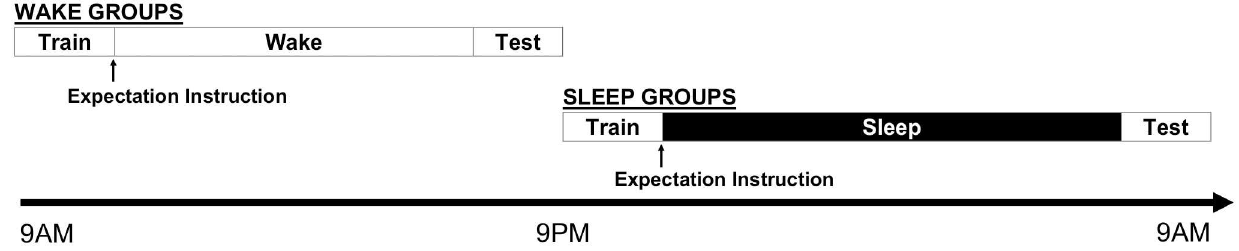
Fig 1. Experimental Design. After training on two learningtasks, participants were retested followingan 11hr delay filled with either wakefulness or sleep. Immediately after encoding, test expected groups were informed that they would be later tested on the same material, whereas test unexpected groups were